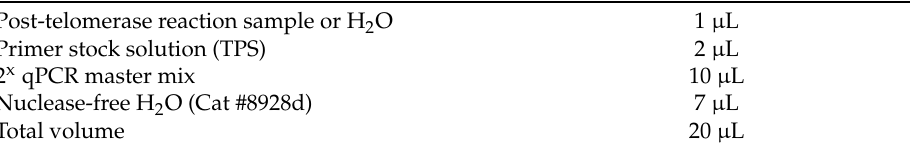
Table 6. Items used in qPCR assay of LightCycler ® 480 II.